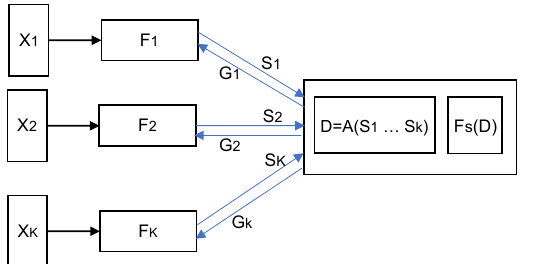
Figure 6. Hybrid SL-FL framework with vertical